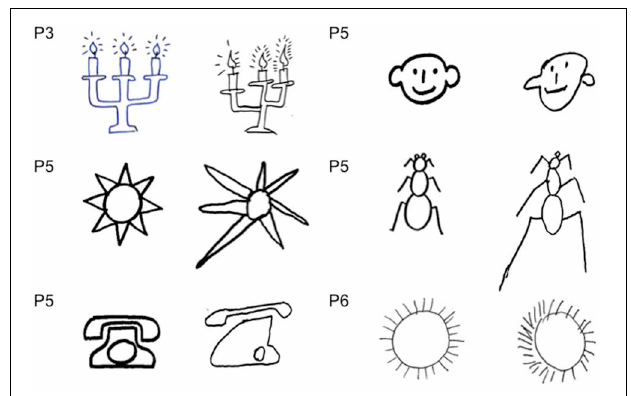
FIGURE 4 | Examples of drawing by copy (P#3: candle), (P#5: star, phone, face, ant), and (P#6: sun).